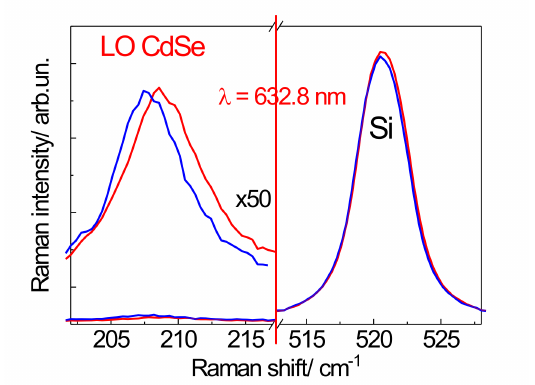
Figure 11. SERS spectra measured on two different single dimers reveal the LO phonon feature around 208 cm − 1 and a frequency shift of 1.1 cm − 1 . Si peaks are shown for reference. Adapted with permission from [41]. Copyright 2016,